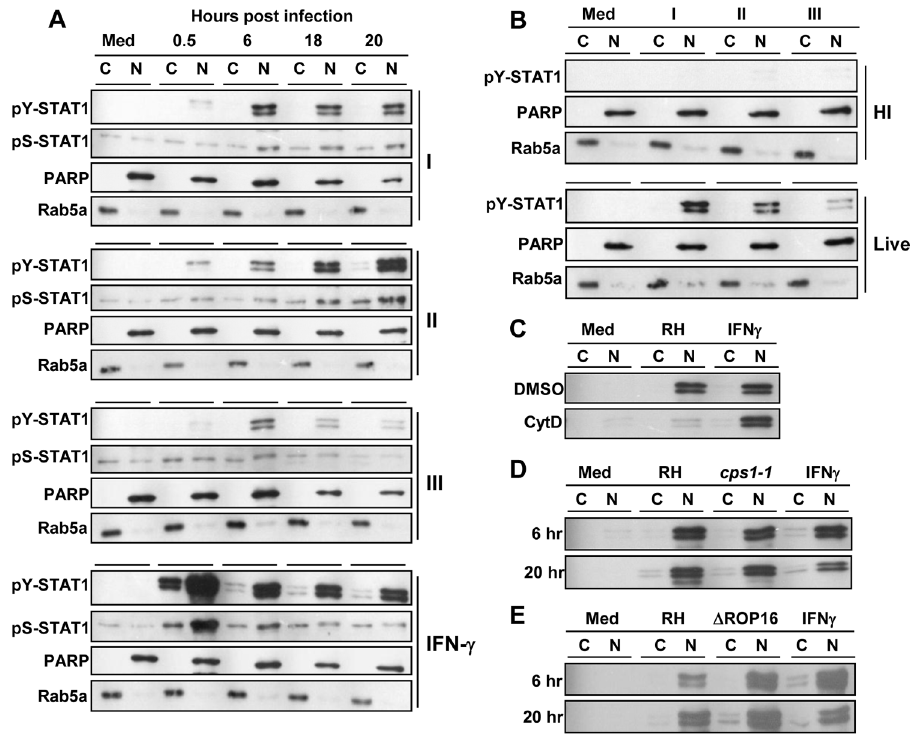
Figure 1. Toxoplasma induces STAT1 phosphorylation and nuclear translocation in BMDC. (A) BMDC were left in medium alone (Med), infected with type I (RH), II (PTG) or III (M774.1) strains of Toxoplasma (3:1 ratio of parasites to cells), or treated with murine IFN c (100 ng/ml), prior to fractionation into cytoplasmic (C) and nuclear (N) extracts at the time points indicated. Samples were subjected to immunoblot analysis for phospho- Tyr701-STAT1 (pY-STAT1) and phospho-Ser-STAT1 (pS-STAT1). PARP and Rab5a served as loading controls for nuclear and cytoplasmic fractions, respectively. (B) Cells were infected with live parasites of the three strains as in (A) or exposed to heat-inactivated (HI) tachyzoites for six hours. Cytoplasmic and nuclear fractions were collected and immunoblot analyis was performed as in (A). (C) RH parasites were pre-treated for 10 min on ice with 1 m M cytochalasin D (CytD) prior to infection in the continued presence of the drug. Cells treated with the solvent DMSO alone served as controls. Cells were fractionated after six hours and subjected to immunoblot analysis for pY-STAT1. (D and E) BMDC were treated with IFN c or infected with RH in comparison with either the cps1-1 replication-deficient strain (D) or the D ROP16 strain (E). Samples were fractionated after 6 and 20 hours and subjected to immunoblot analysis for pY-STAT1. All experiments were repeated at least three times with similar